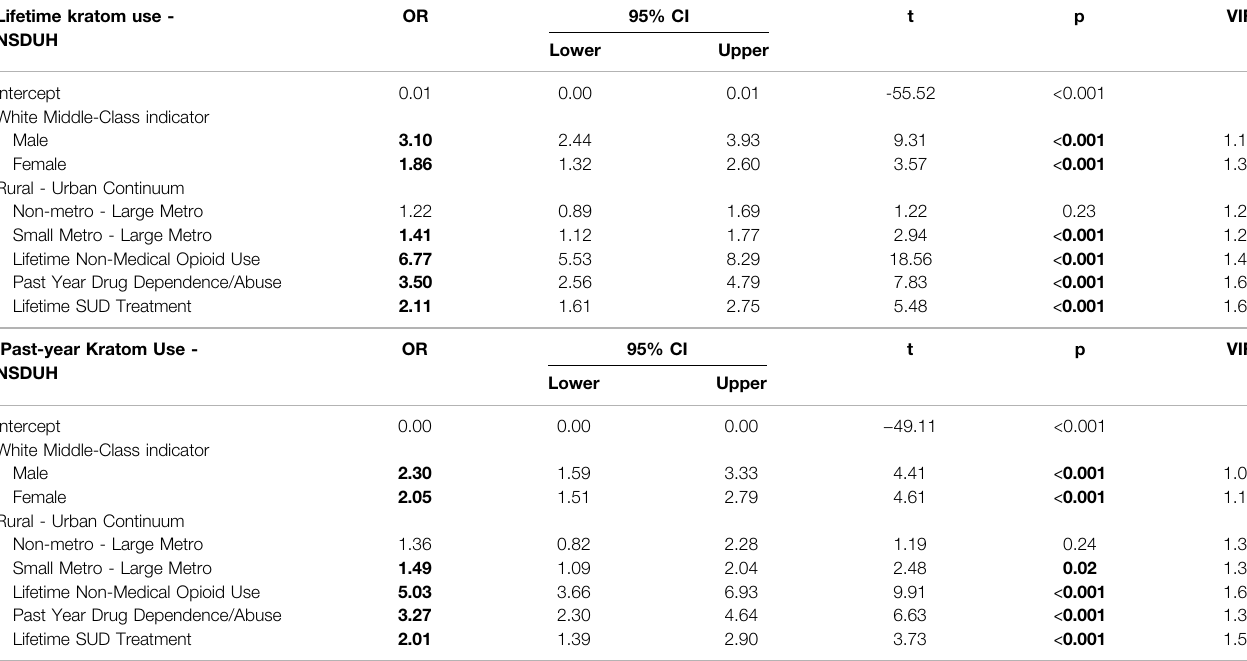
TABLE 6 | Survey-weighted multiple logistic regression models using nationally representative NSDUH 2019 to examine the relationship between a “ white middle-class ” indicator and kratom use while controlling for substance use factors. Lifetime kratom use - NSDUH